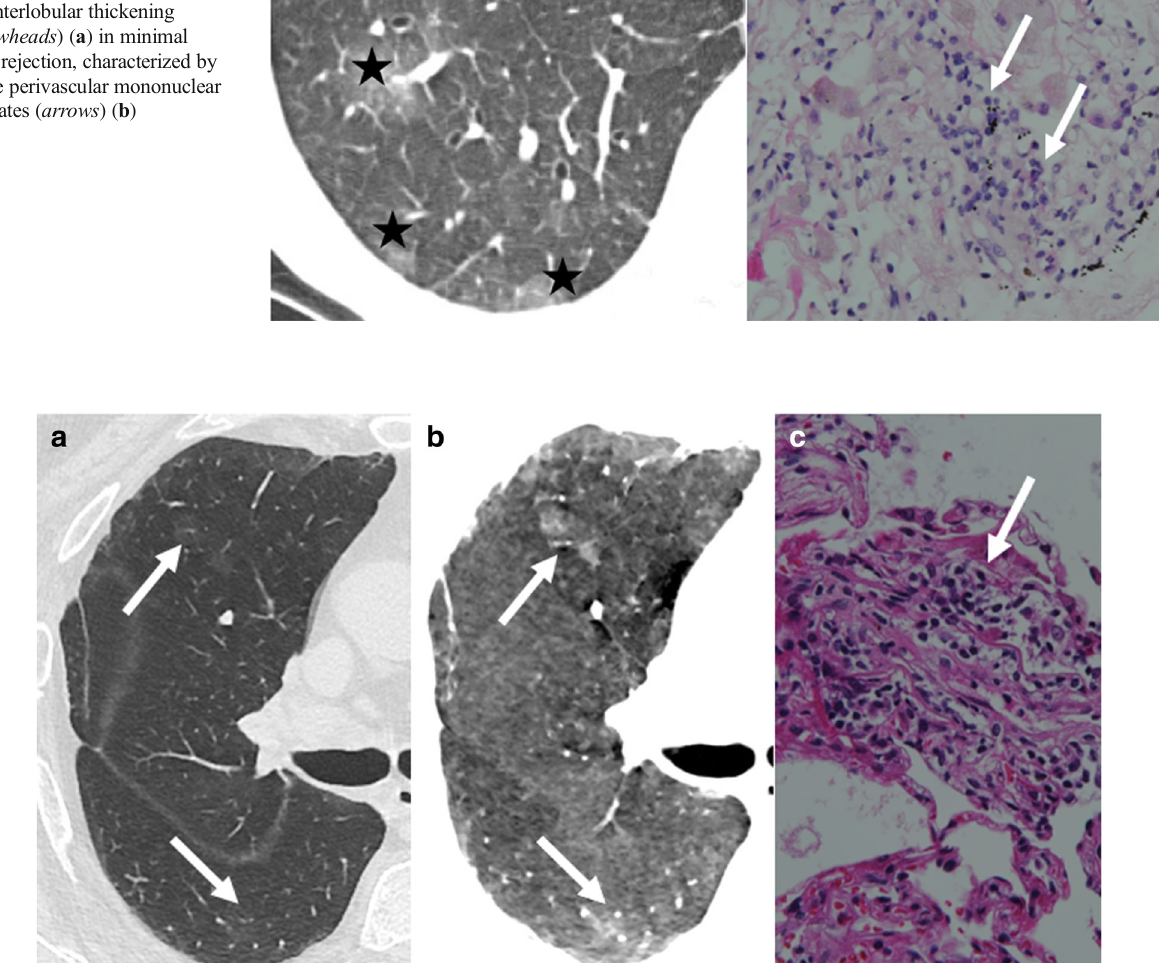
Fig. 7 Acute rejection A1. Ground-glass opacities ( stars ) and interlobular thickening ( arrowheads ) ( a ) in minimal acute rejection, characterized by sparse perivascular mononuclear